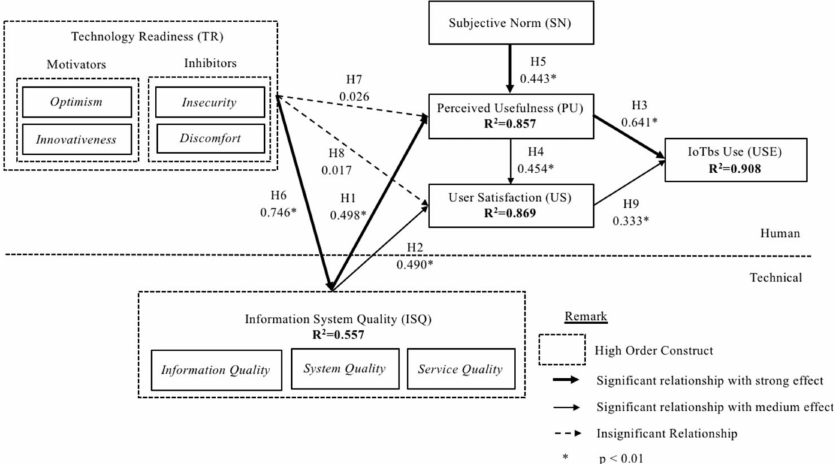
Figure 2. Structural model analysis results.